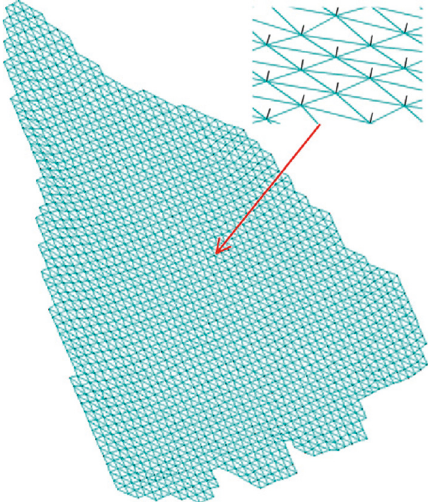
Figure 18: The design sketch of pore water